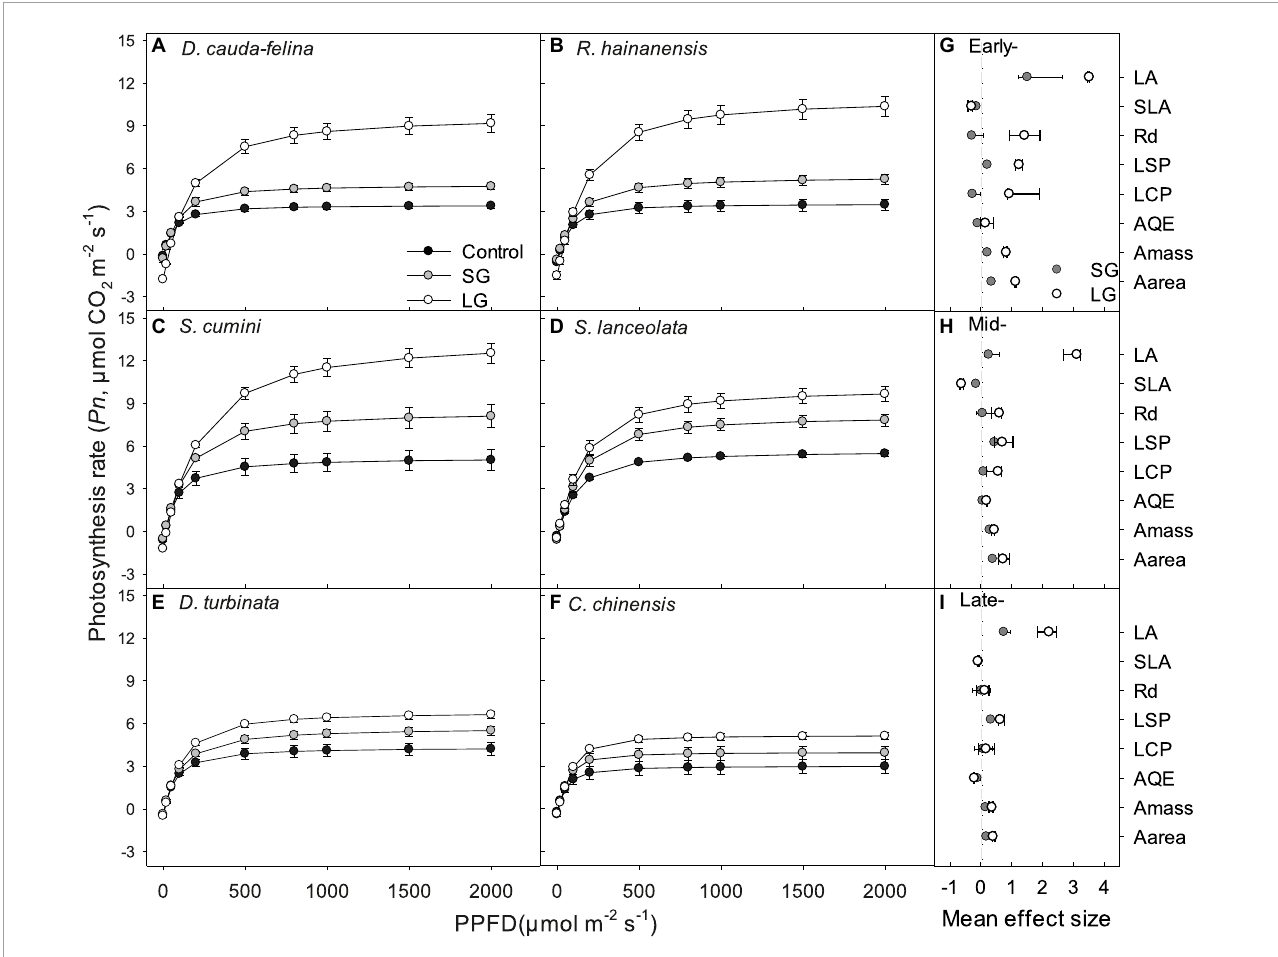
FIGURE2 Photosynthetic light response curves (A–F) for seedlings grown in light conditions under Control, SG and LG, and the mean effect size (G–I) of SG and LG on leaf area (LA), specific leaf area (SLA), dark respiration (R d ), light saturation point (LSP), light compensation point (LCP), apparent quantum efficiency (AQE), mass-, and area- based light saturated rate of CO 2 assimilation (A mass and A area ) for seedlings at early- (G) , mid- (H) and late-successional stage (I) . Control: 0–5% of full sunlight; SG: small canopy gaps, 10–15% of full sunlight; LG: large canopy gaps, 40–50% of full sunlight. Light curves were fitted by non-linear regression using non-rectangular hyperbola least square curve fitting procedure (Lambers et al., 1998). Data points in plots (A–F) and (G–I) represent mean ± s.e. [standard error, n = 25 (5 plants × 5 leaves)] and mean ± CI (the 95% confidence interval), respectively. If the CI in plots (G–I) did not overlap with zero (the gray dotted line), a significant mean effect of SG and/or LG was considered ( P <